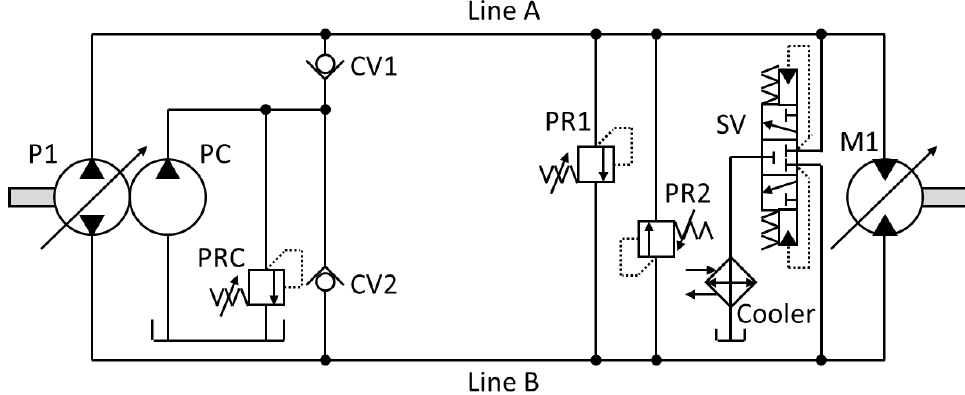
Figure 6. Transmission Schematic for Proposed Solution C.